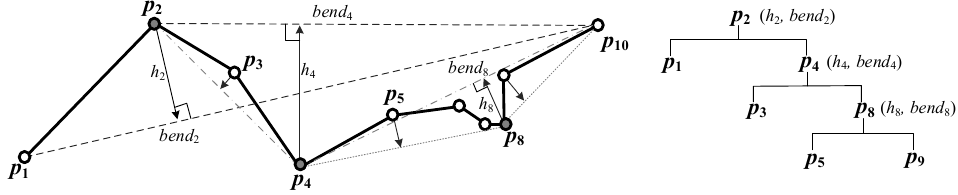
Figure 4. Calculating the turning distance ratio based on bend hierarchical tree